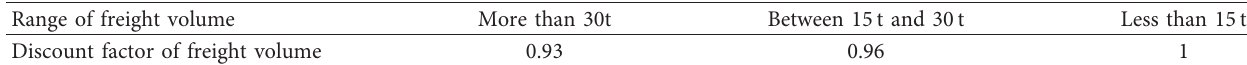
Table 4: Discount factor of freight volume.